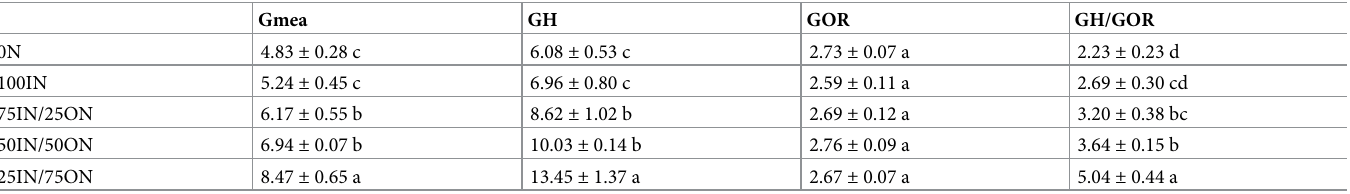
Table 5. Changes in the geometric mean of the assayed enzyme activities (Gmea), hydrolase (GH) and oxidase (GOR) under different fertilization treatments.